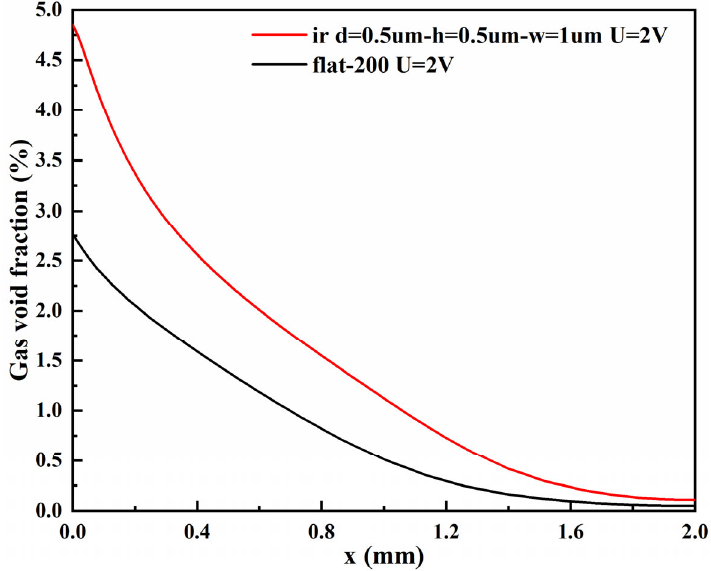
Figure 10. The gas void fraction curves of micro-nano surface and vertical flat electrodes at the top of the H 2 compartment under the same voltage (U = 2 V).